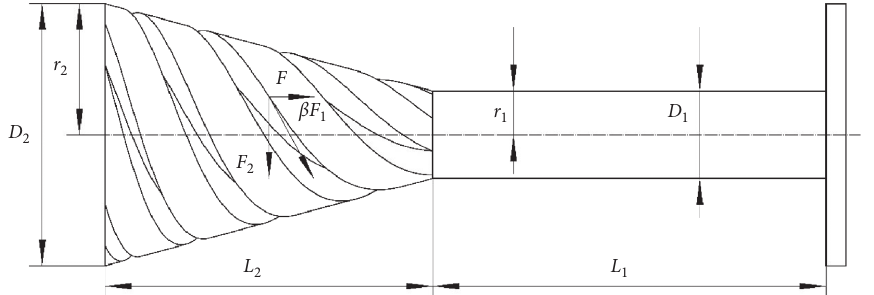
Figure 5: Spiral groove